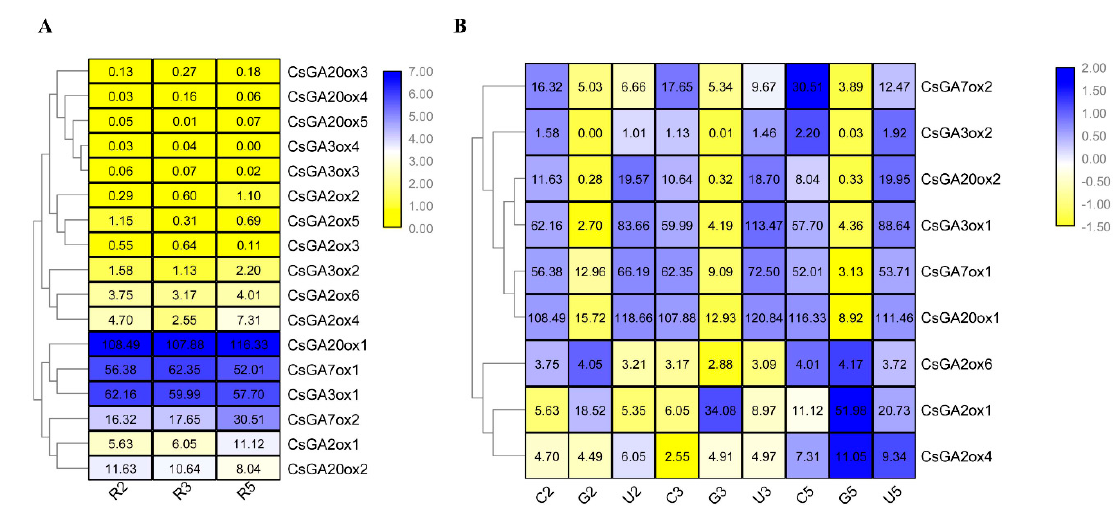
Figure 4. Heatmap of the expression profiles of CsGAox family genes in roots under control, GA 3 and Uni treatments. ( A ) The developmental expression pattern analysis of CsGAox family genes at 3 developmental stages during roots growth. R2, R3 and R5 represent roots at 2, 3 and 5 days after seed germination under normal condition; Clustering was based on log2-transformed FPKM values of 17 CsGAox genes; ( B ) Expression pattern analysis of CsGAox family genes at 3 developmental stages of root under control, GA 3 and Uni treatments. C2, C3 and C5 represent roots at 2, 3 and 5 days after seed germination under normal condition; G2, G3 and G5 represent roots at 2, 3 and 5 days after seed germination under 50 µ M GA 3 treatment; U2, U3 and U5 represent roots at 2, 3 and 5 days after seed germination under 10 µ M Uni treatment. Clustering was based on Z-score row-scaled for each gene after log2-transformed FPKM values. The expression data was gained from the RNA-seq data with three biological replicates. Values, which were shown on the heatmaps, represent the average FPKM value of three biological replicates.